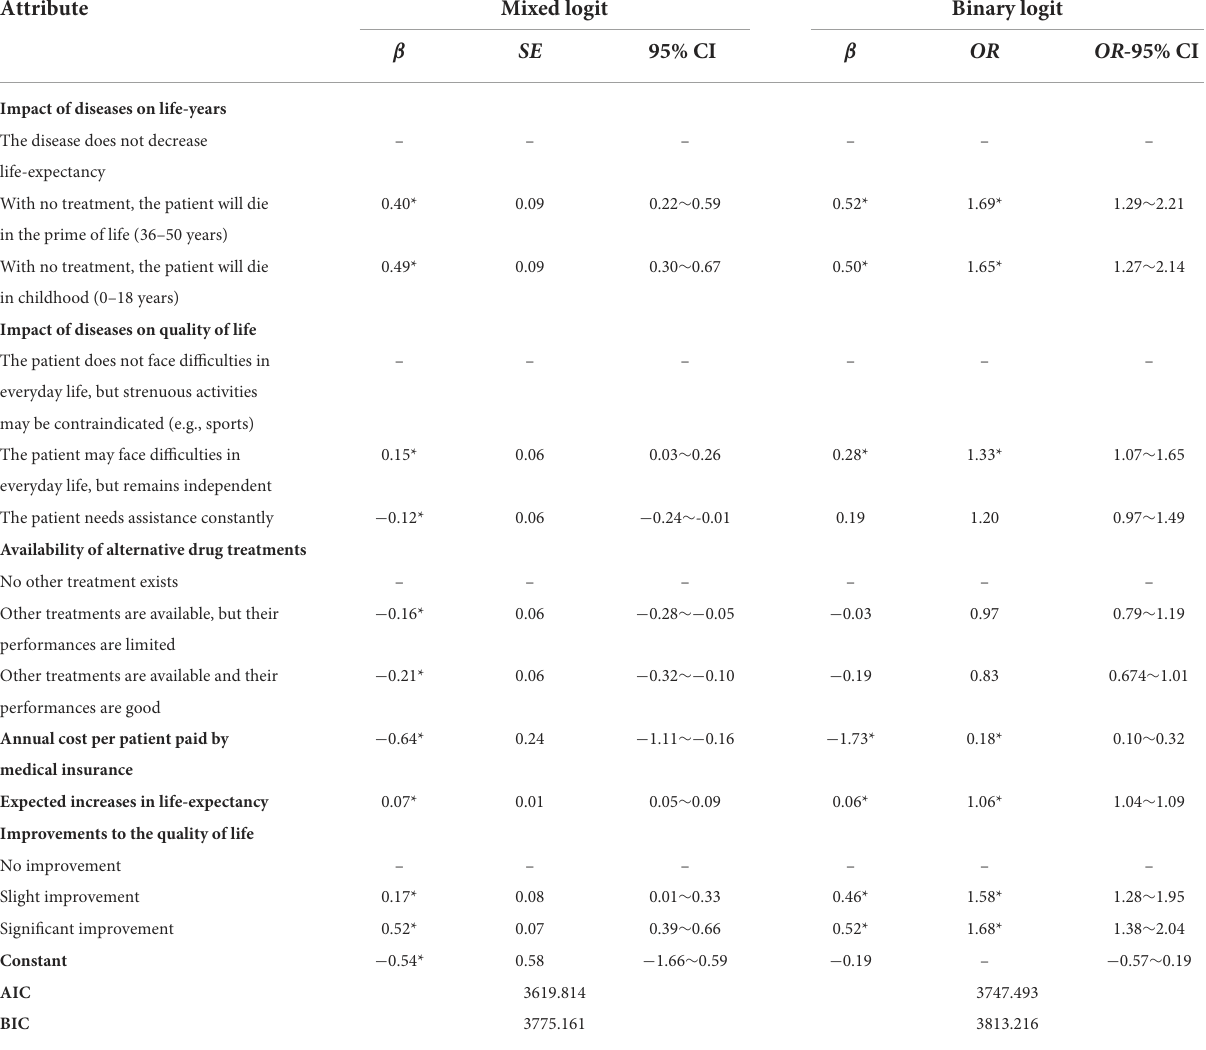
TABLE 3 Results of Mixed logit model and Binary logit model.